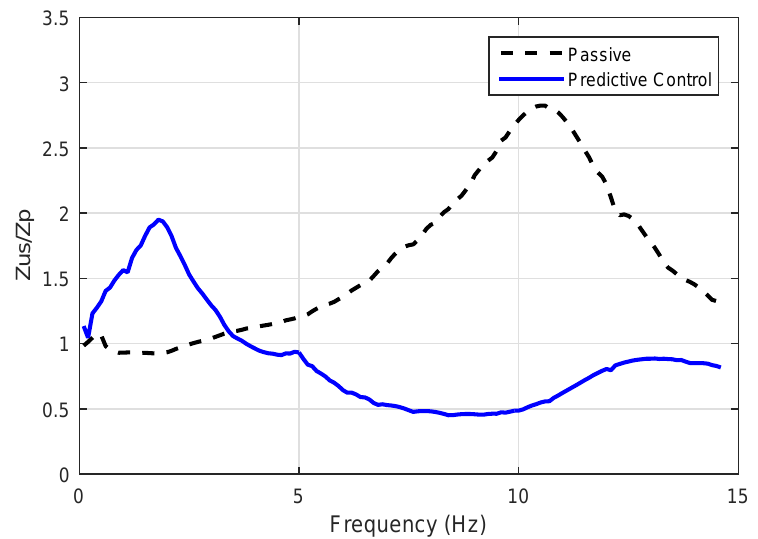
Figure 4. Unsprung mass displacement gain ( z us / z p ) for the passive and predictive